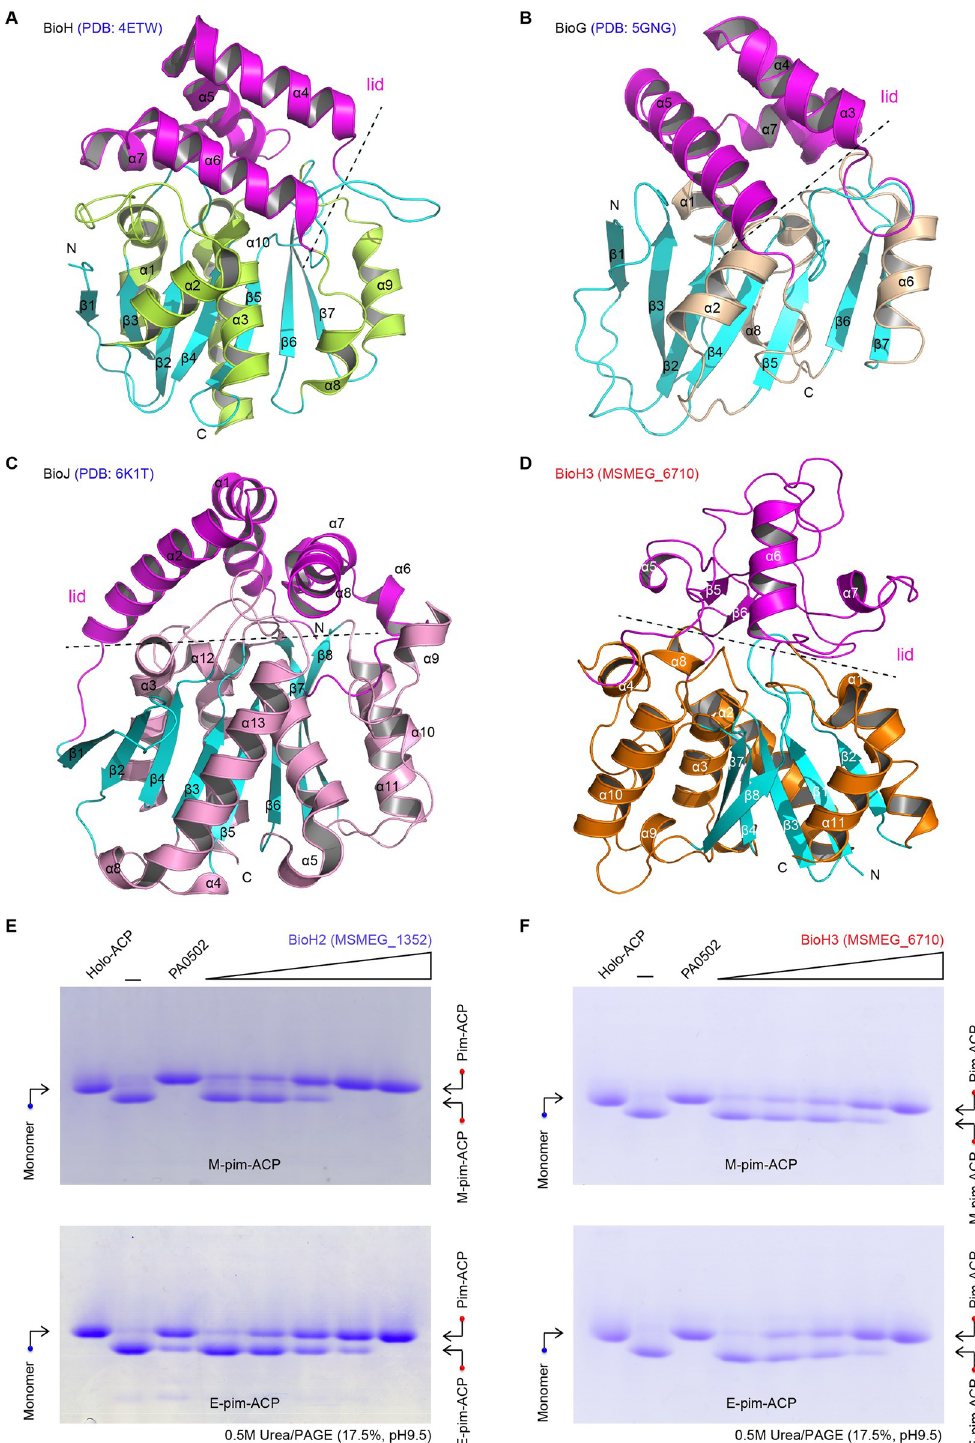
Fig 4. Functional and structural analysis of the two biochemically-amenable demethylases BioH2 and BioH3. Ribbon structures of three known biotin gatekeeper enzymes BioH ( A ), BioG ( B ), and BioJ ( C ). D. Ribbon presentation of the monomeric structure of BioH3 (MSMEG_6710). BioH3 seemed unusual in that its lid domain displays a unique folding mode compared with the other three known enzymes. E. BioH2 (MSMEG_1352) is enzymatically active, albeit of its aggregation in solution. F. BioH3 (MSMEG_6710) displays enzymatic activity of removing the methyl (ethyl) moiety from